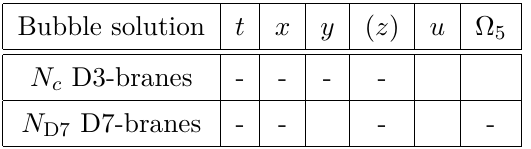
Table 2 . The configuration of the D-branes in the bubble solution